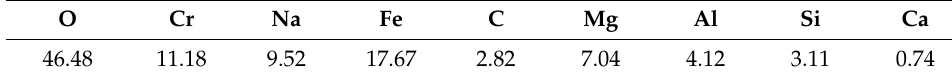
Table 3. Brief chemical components of the slag after ultrasonic